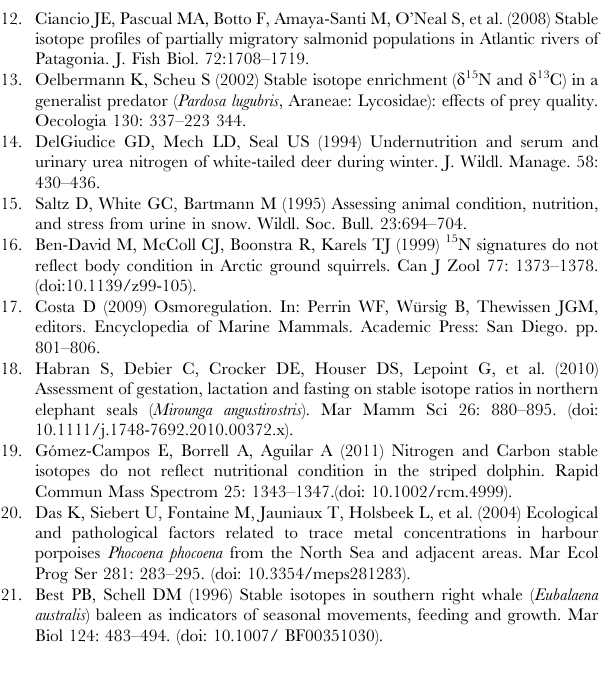
Table S1 Biological information of the individuals sampled and d 15 N values measured in their muscle . Table S2 d 15 N values measured in the various sampling points of the baleen